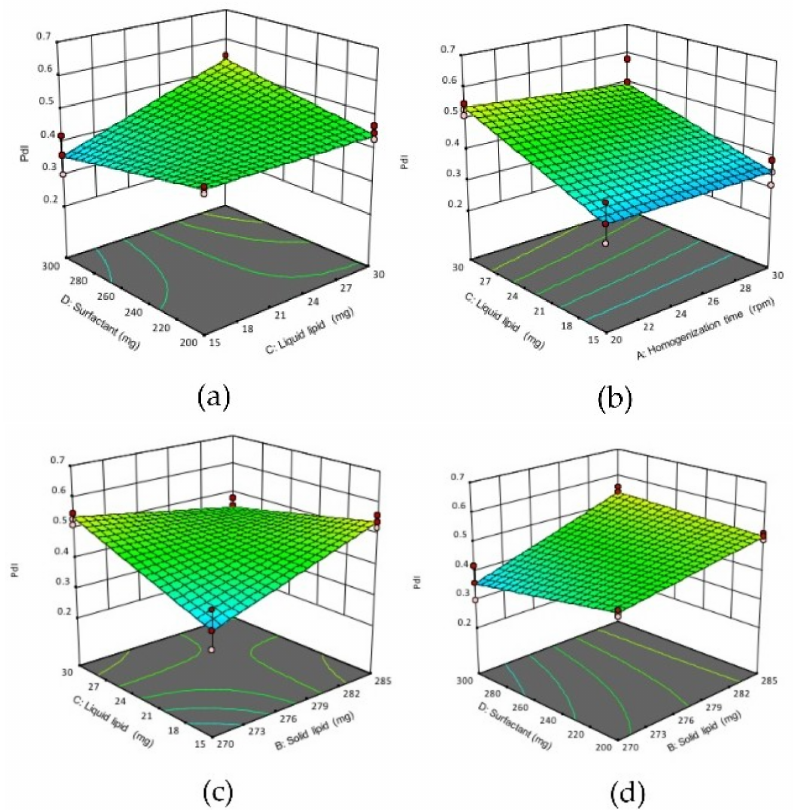
Figure 2. 3D response surface plots showing the effect of interactions between ( a ) CD, ( b ) AC ( c ) BC and ( d ) BD on the PdI of NLCs. ( A ) homogenization time, ( B ) solid lipid concentration, ( C ) liquid lipid concentration, ( D ) surfactant